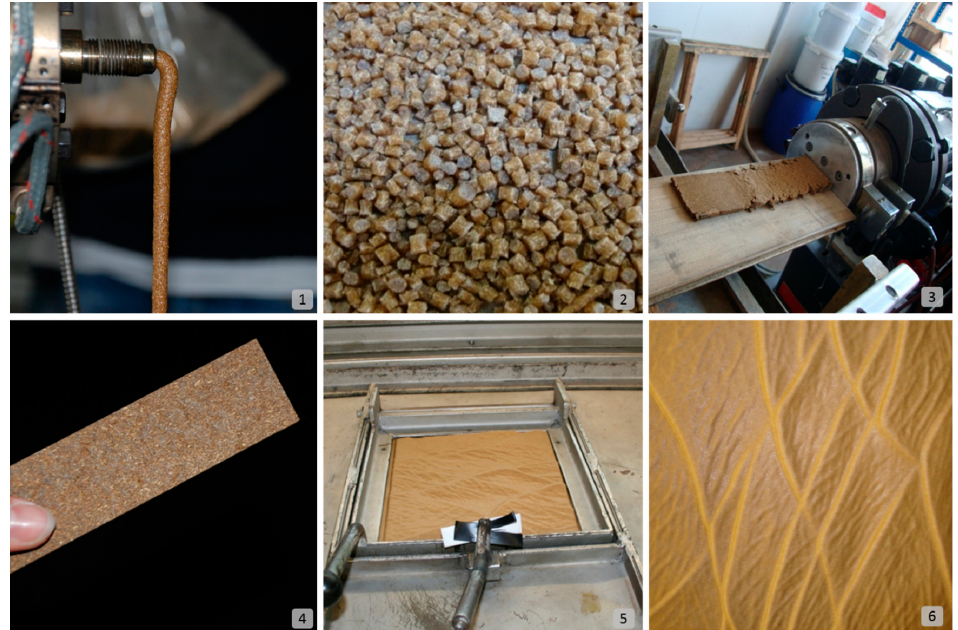
Figure 1. Up: ( 1 ) Compounding, ( 2 ) pelletising, and ( 3 ) extrusion processes. Down: ( 4 ) Cut panel, ( 5 ) the thermoforming-process of a thermoplastic biocomposite panel, and ( 6 ) a thermoformed final finished panel (photos: Dahy, H.; republished [8]).